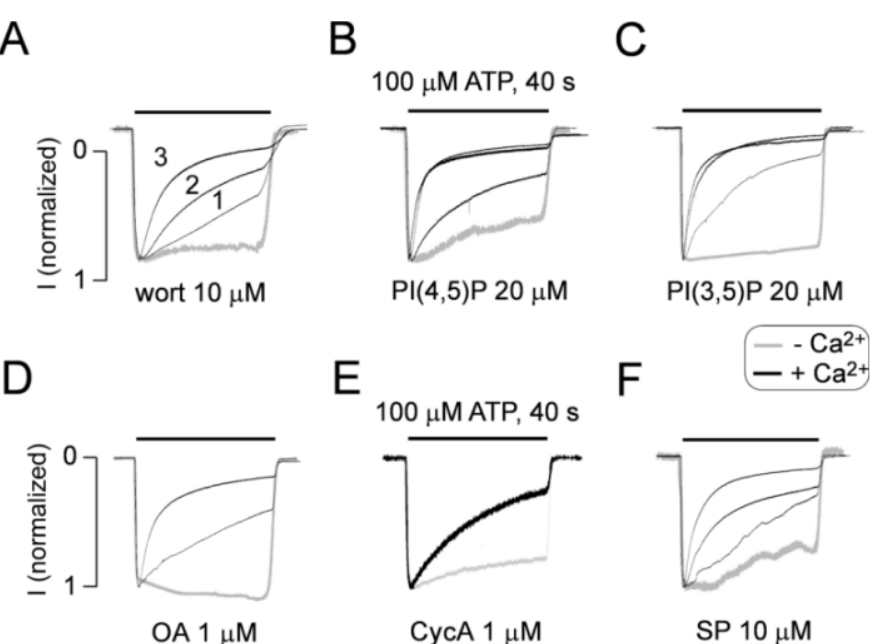
Figure 6. Independence of UDD of the status of kinases, phosphatases, and phosphoinositides in the absence of intracellular ATP. The results show whole-cell recordings from P2X2aR-expressing HEK293 cells clamped at − 60 mV and containing kinase and phosphatase inhibitors or activators in the absence (gray traces) or in the presence (black traces) of 2 mM extracellular calcium. ( A – F ) The lack of effects of wortmannin (WT), an inhibitor of PI 3 and PI 4 kinases ( A ), the phosphoinositides PI(4,5)P 2 ( B ) and PI(3,5)P 2 ( C ), the phosphatase PP2B inhibitor okadaic acid (OA) ( D ), the calcineurin inhibitor cyclosporin A (CycA) ( E ) and staurosporine (SP), a nonselective kinase inhibitor at the concentration used ( F ), on the development of UDD during repetitive agonist application. The cells were dialyzed for 7 min before the start of the experiment, and the washout periods between ATP applications were 4 min each. The recordings shown are representative of at least 3 different